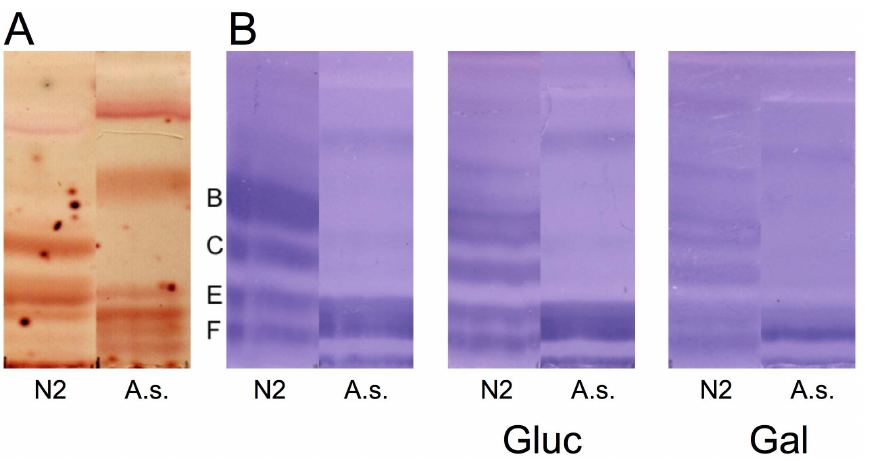
Figure 1. A.suum expresses Cry5B glycolipid receptors. A. Orcinol staining of upper phase glycolipids from mixed-staged C. elegans (N2) and A. suum fourth-stage larvae (A.s.). The glycolipid profiles of the two are different. B. Cry5B binding to glycolipids from C. elegans (N2) and A. suum (A.s.) in the absence of sugar (left panel), presence of 100 mM glucose (middle panel), and presence of 100 mM galactose (right panel). The profile of Cry5B-binding glycolipids (left panel) is different from both nematodes (bands B, C, E, and F refer to Cry5B-binding glycolipids as noted in [27]). The intensity of all bands is reduced in the presence of galactose.